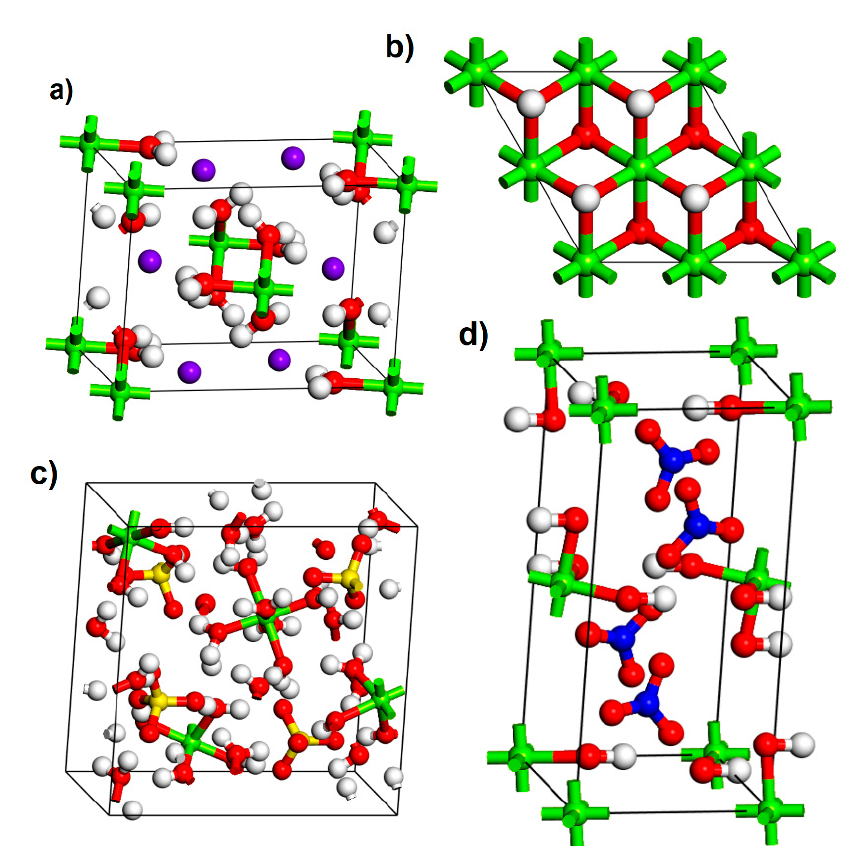
Figure 3. Snapshots of four di ff erent MgO-containing crystal structures ( a ) MgCl 2 · 6H 2 O, ( b ) Mg(OH) 2 , ( c ) MgSO 4 · 7H 2 O, and ( d ) MgNO 3 · 6H 2 O. Atom colors: Mg (green), O (red), H (white), Cl (purple), S (yellow), and N (blue).